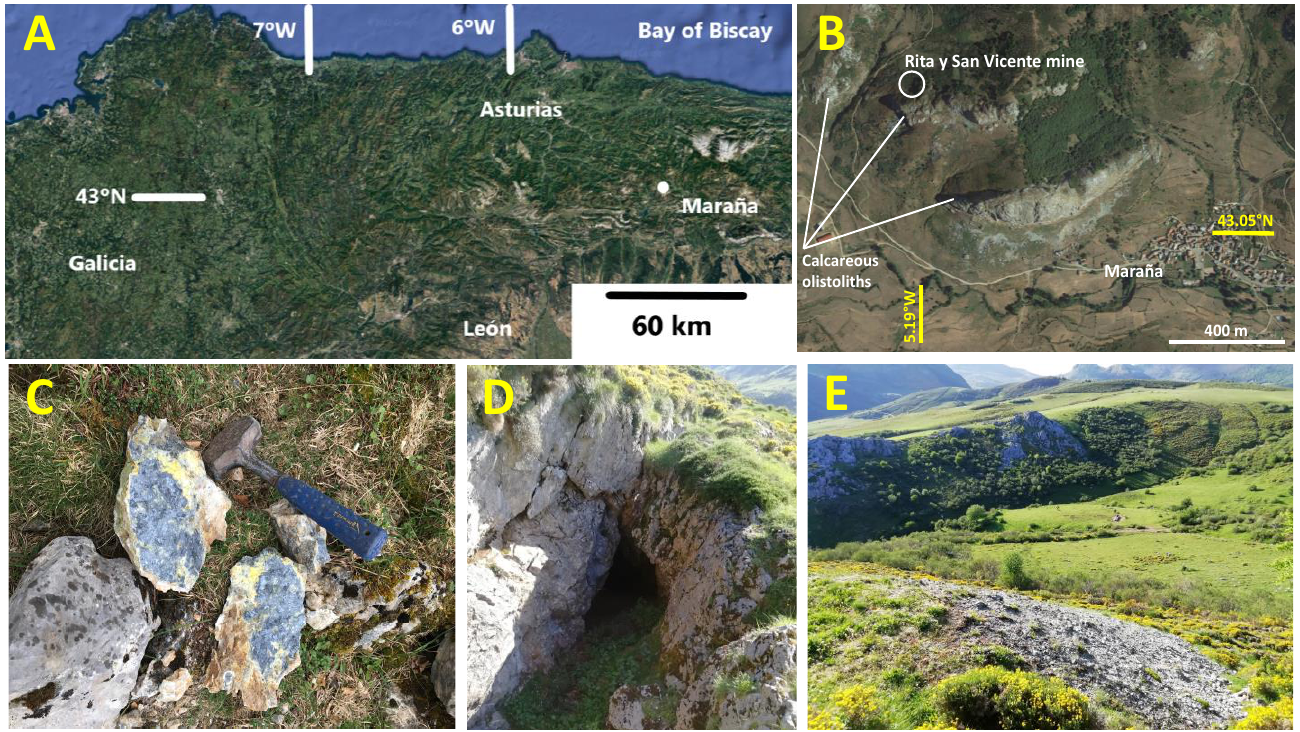
Figure 1. ( A , B ) Location of the Rita y San Vicente mine, NW of the locality of Maraña; ( C ) stibnite and Sb ochre mineralization; ( D ) upper mining works; ( E ) spoil heap.